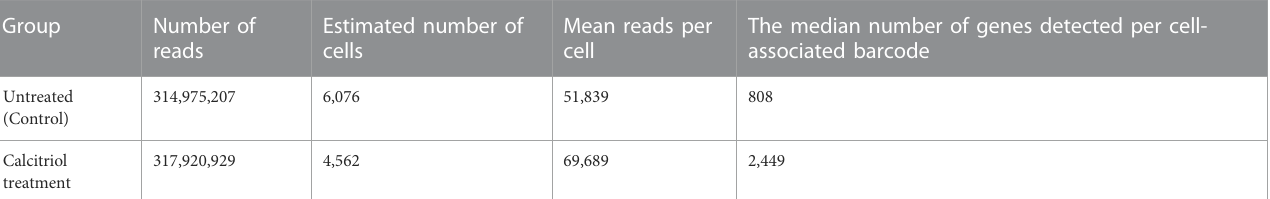
TABLE 2 Results of single-cell RNA sequencing